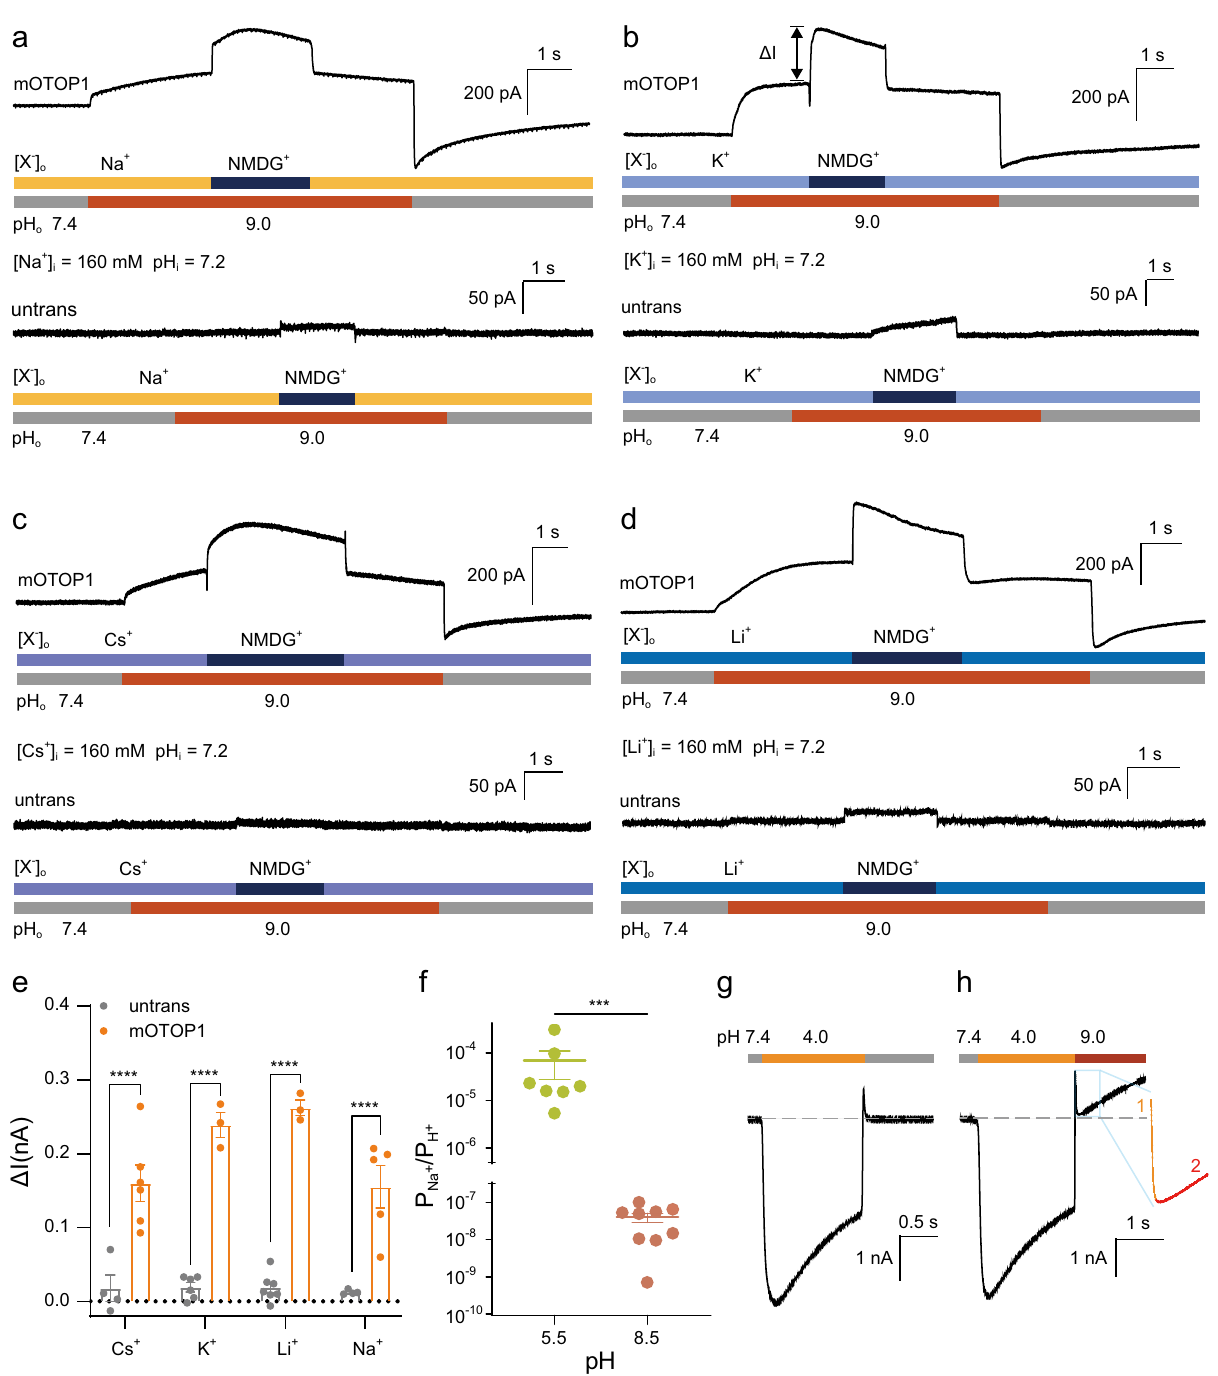
Fig. 3 | OTOP1 channels permeated multiple cations when activated by alkali. a – d NMDG + inextracellularsolutionwasreplacedwithanequimolarconcentration of Na + ( a ), K + ( b ), Cs + ( c ), or Li + ( d ) to measure ionic selectivity of OTOP1. Extra- cellularsolutionpH(7.4)wasmaintainedwith160mMNa + ,K + ,Cs + ,orLi + bothinside and outside the cell. The current amplitude increased and was greater than that in the untransfected HEK293Tcells when the dosing tube was switcheddirectly from pH 9.0 extracellular solution containing other cations to pH 9.0 extracellular solution containing 160mM NMDG + . [X + ] o , extracellular cation ion concentration; [Na + ] i , intracellular Na + concentration. pH i , intracellular pH; pH o , extracellular pH. e HEK293T cells expressing OTOP1 channels showed signi fi cantly higher increases in currents when other cations were permeated compared to untransfected